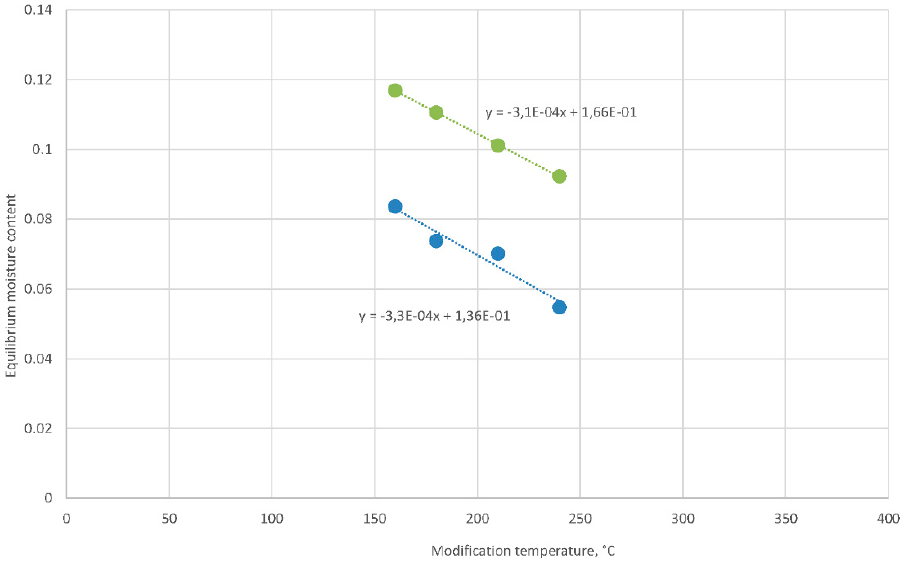
Figure 6. Increase in the equilibrium moisture content of oak wood in humid air (temperature of 20 ◦ C and relative humidity of 65%) modified with temperatures of 160–240 ◦ C (blue dots) after soaking (temperature of 20 ◦ C) and following the equilibrium in humid air (green dots).